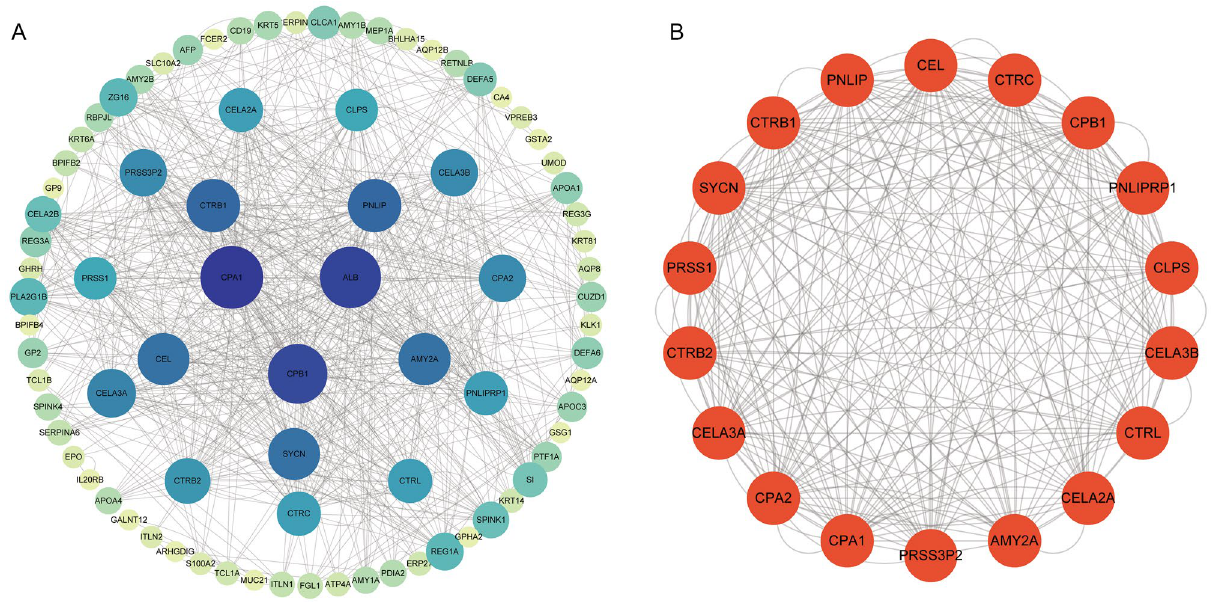
Figure 6. The PPI network of DEGs associated with RAB7A and the key modules contained inside. ( A ) The Cytoscape was used to design the DEG PPI network. ( B ) The most important module is the PPI network with 18 nodes and 260